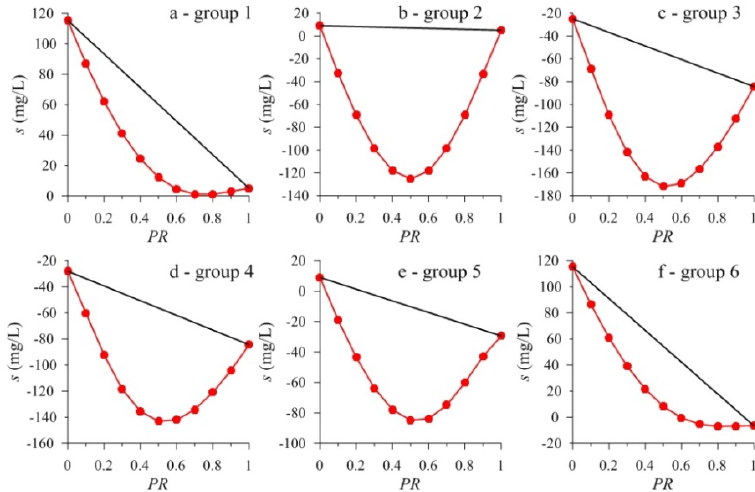
for the six groups of mixed water. The Figure 1. Dissolution (Precipitation) of CaCO 3 x -axis PR is the mixing ratio, and the y -axis s is the dissolution amount of CaCO in mixed 3 waters (“+”: dissolution, “ − ”: precipitation). The red curve represents the calculated results ), and the black line is the results under no mixing considering mixing precipitation ( s 1 precipitation assumption ( s 2